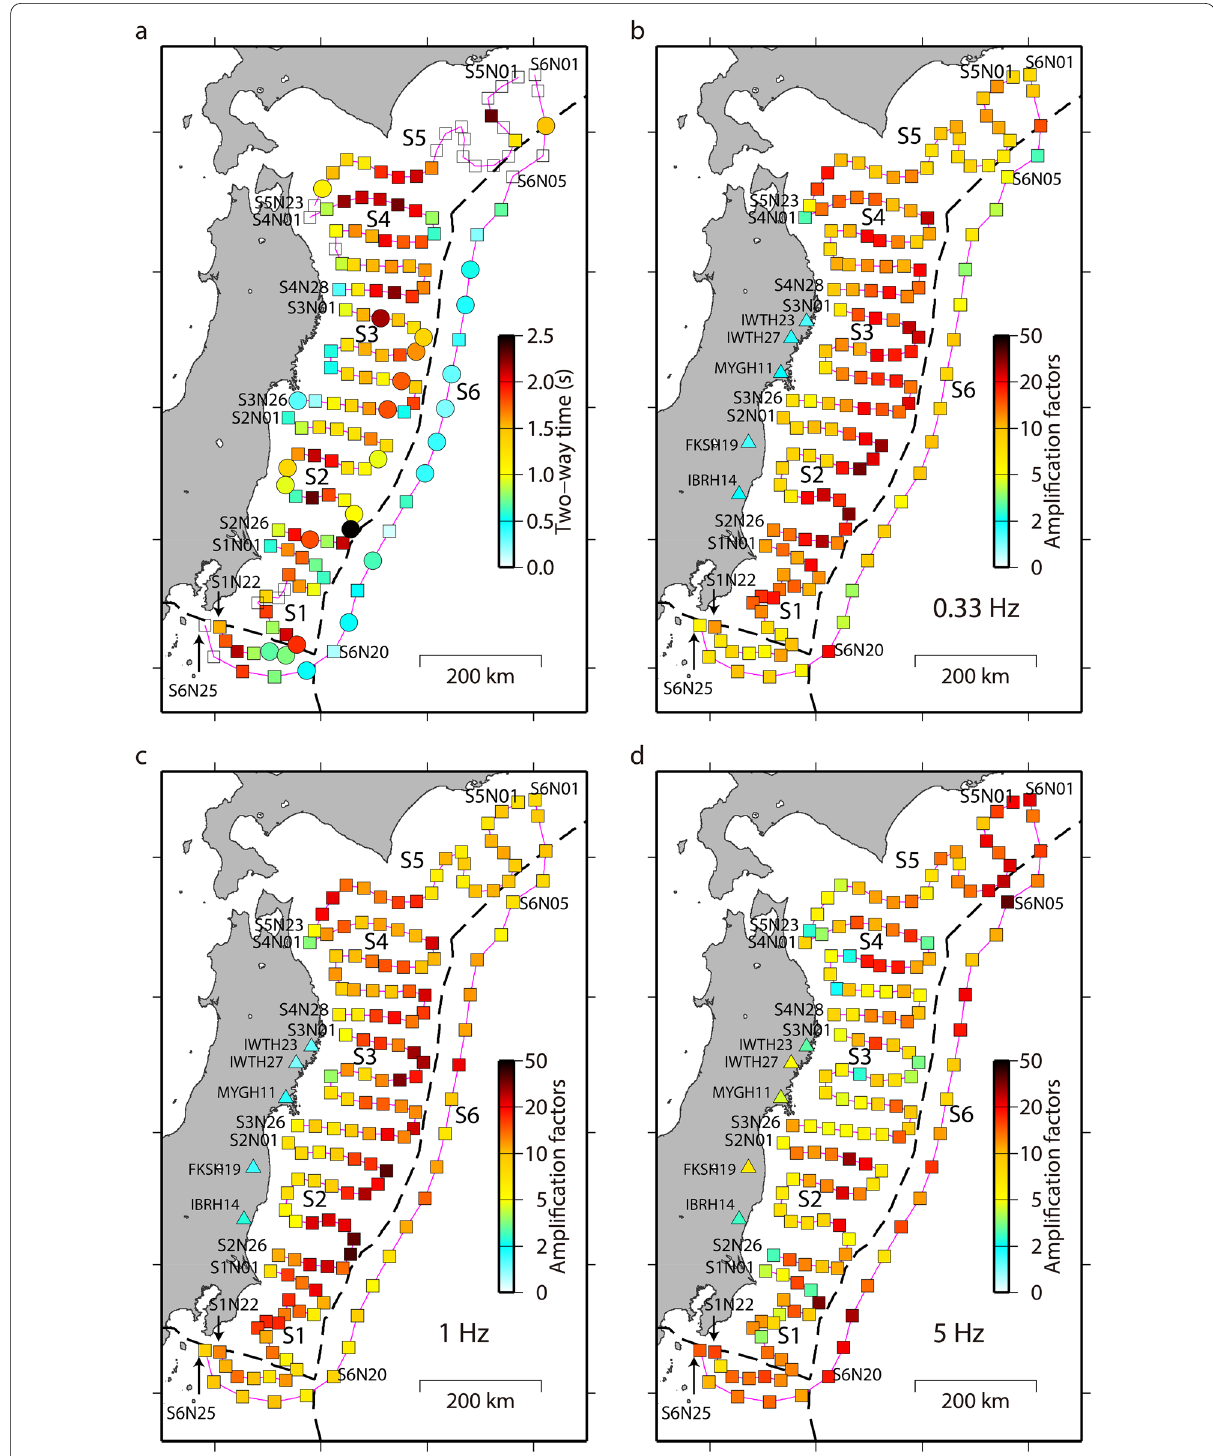
Fig. 14 a Two-way travel time for P wave from the base of sediment to the seafloor estimated by multi-channel seismic (MCS) reflection survey (Nishizawa et al. 2022). The color filled squares and circles denote the sites located, within and beyond 5 km from the survey line, respectively. The open squares denote the sites, where the travel times were not estimated. b , c , and d Amplification factors at frequencies of approximately 0.33, 1, and 5 Hz,